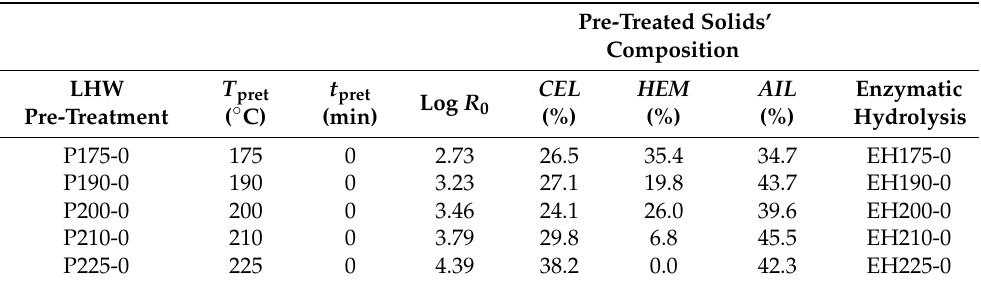
Table 2. Effect of liquid hot-water (LHW) pre-treatment temperature ( T pret ) on the composition of pre-treated solids.